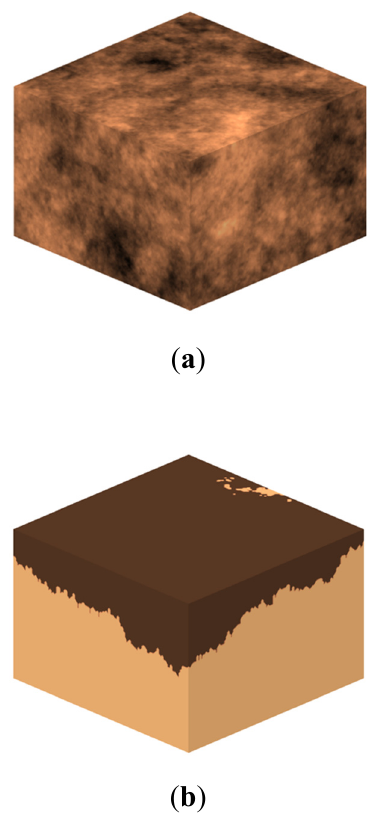
Figure 2. Example virtual soils; ( a ) a single layer profile with a coefficient of variation (COV) of 80% and scale of fluctuation (SOF) of 15 m; and ( b ) a two-layer soil with a stiffness ratio of 1:9, boundary depth of 10 m, and boundary standard deviation of 4 m.